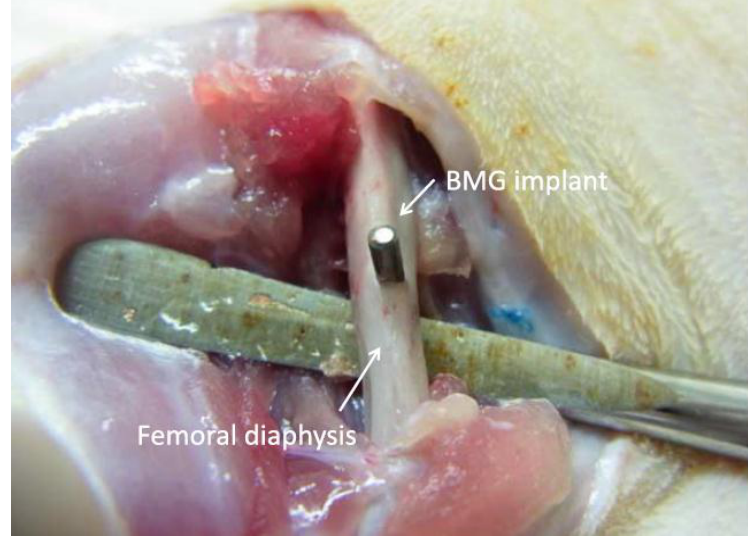
Figure 16. Macroscopic view of the Ti 40 Zr 10 Cu 34 Pd 14 Sn 2 BMG sample at 12 weeks after implantation in femoral diaphysis. Reproduced with permission from [230]. Copyright 2015, IOS press.